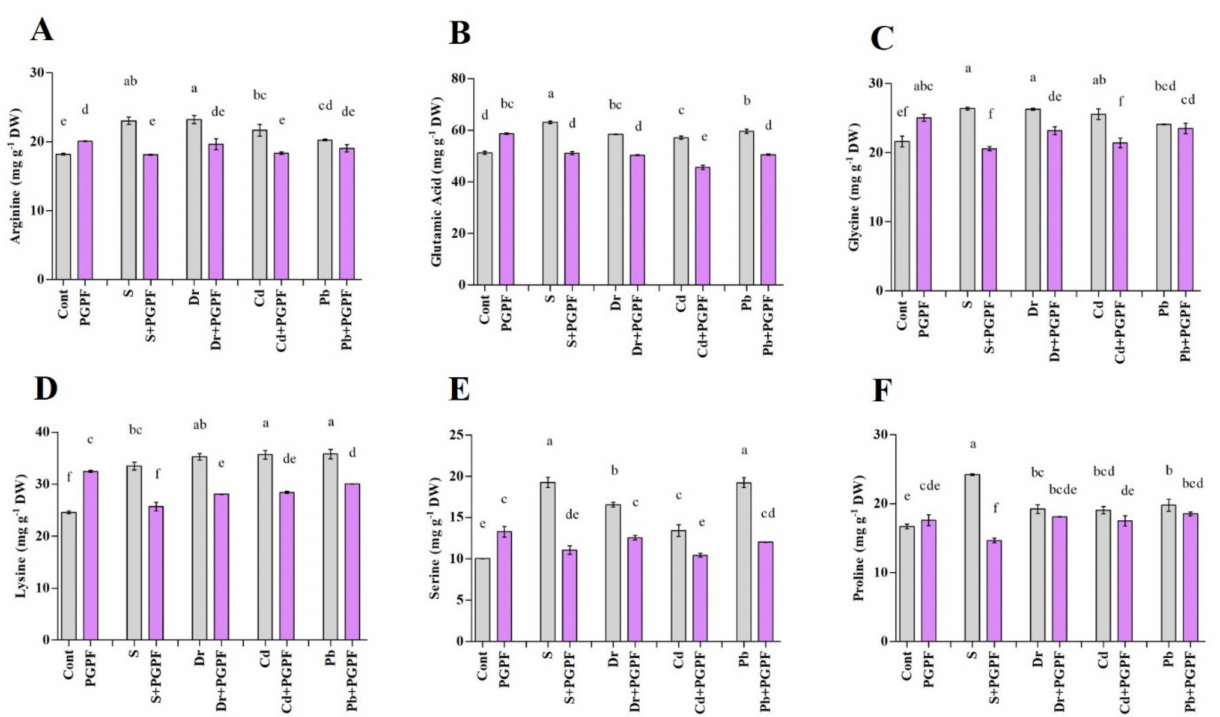
Figure 6. Changes in amino acid contents (( A ) Arginine, ( B ) Glutamic acid, ( C ) Glycine, ( D ) Lysine, ( E ) Serine, and ( F ) Proline) in leaves of tomato plants grown under normal and stress conditions and inoculated with PGPF for 10 days. Treatments: Cont (control), PGPF ( Cunninghamella bertholletiae ), S (1.5% sodium chloride), S (1.5% sodium chloride) + PGPF ( Cunninghamella bertholletiae ), Dr (25% polyethylene glycol), Dr (25% polyethylene glycol) + PGPF ( Cunninghamella bertholletiae ), Cd (3 mM cadmium), Cd (3 mM cadmium) + PGPF ( Cunninghamella bertholletiae ), Pb (3 mM lead), and Pb (3 mM lead) + PGPF ( Cunninghamella bertholletiae ). Values are shown as the means ± SD ( n = 5) and significant differences at p < 0.05 (Tukey test) are indicated by different lowercase letters above the